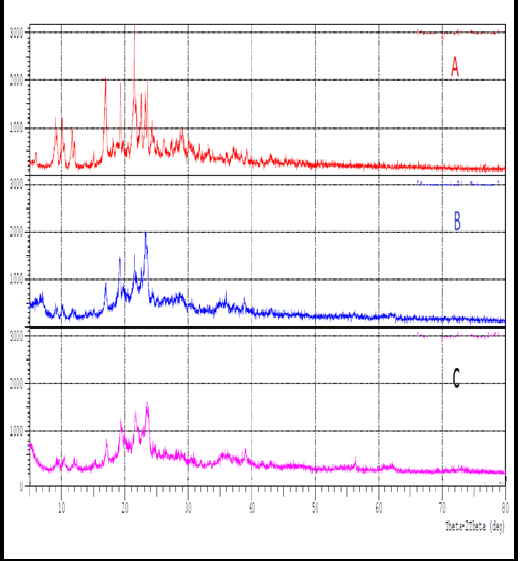
Figure4. X-ray diffractograms of ATR(A), PM (B)and solid dispersion adsorbate of selected formula SDA12